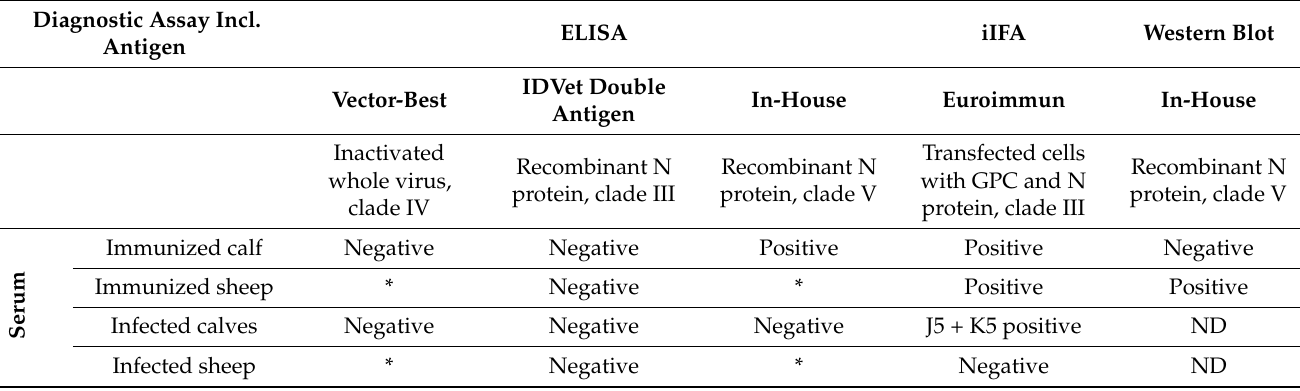
Table 4. Results obtained with Crimean-Congo hemorrhagic fever orthonairovirus (CCHFV) assays and DUGV antisera. Diagnostic Assay